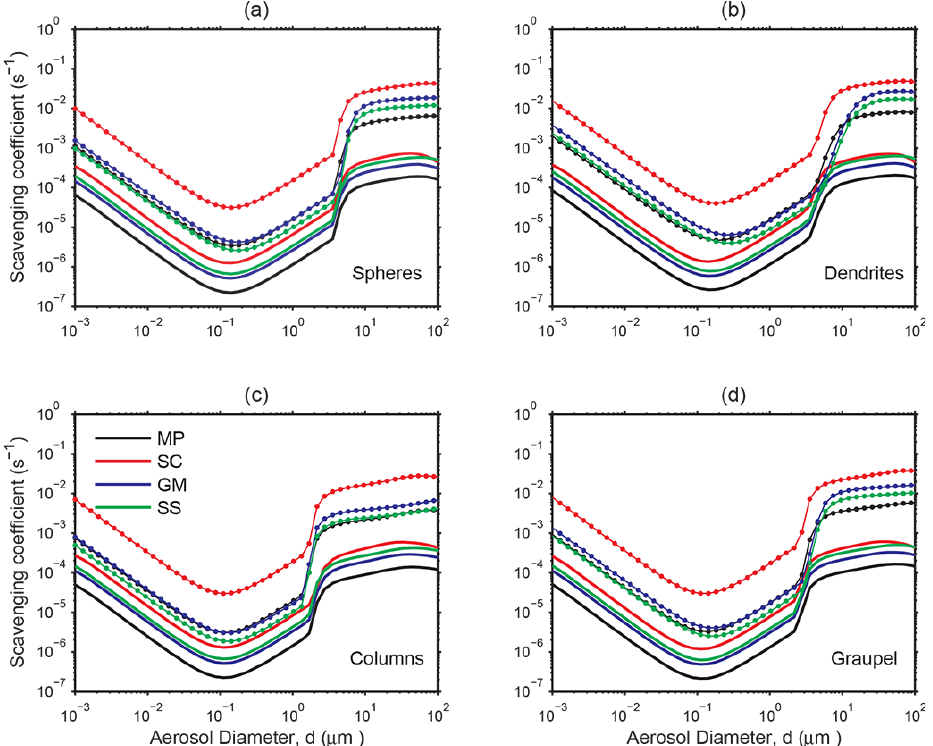
Fig. 4. Size-resolved snow scavenging coefficient profiles obtained using the four different snow-particle number size distributions shown in Fig. 3 for snowfall intensities (as liquid water equivalent) of 0.1 (solid line) and 10mmh − 1 (symbol line) for four different snow-particle